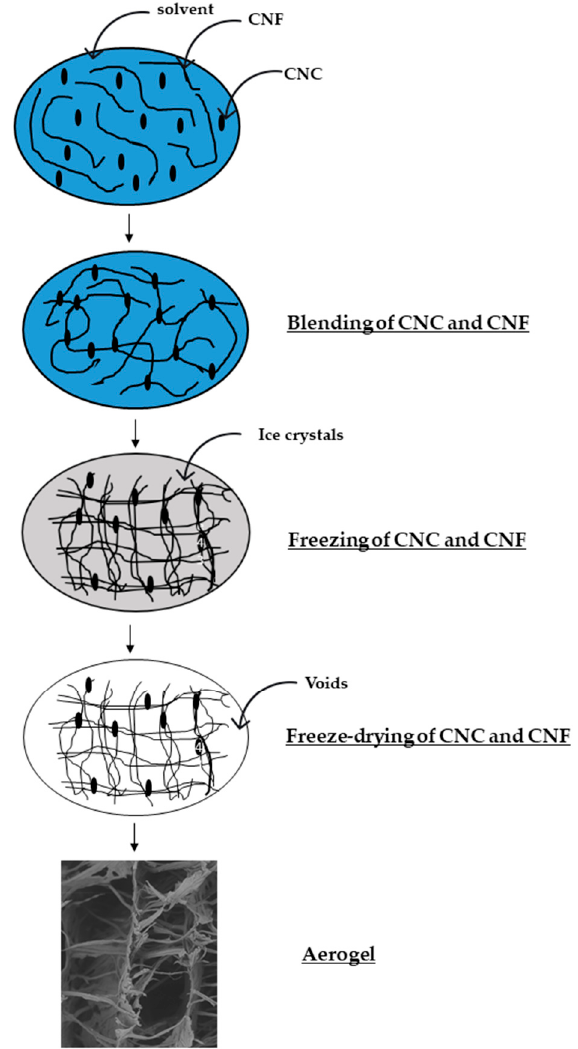
Figure 4. Hypothesis schematic of the fabrication of CNC/CNF aerogel.